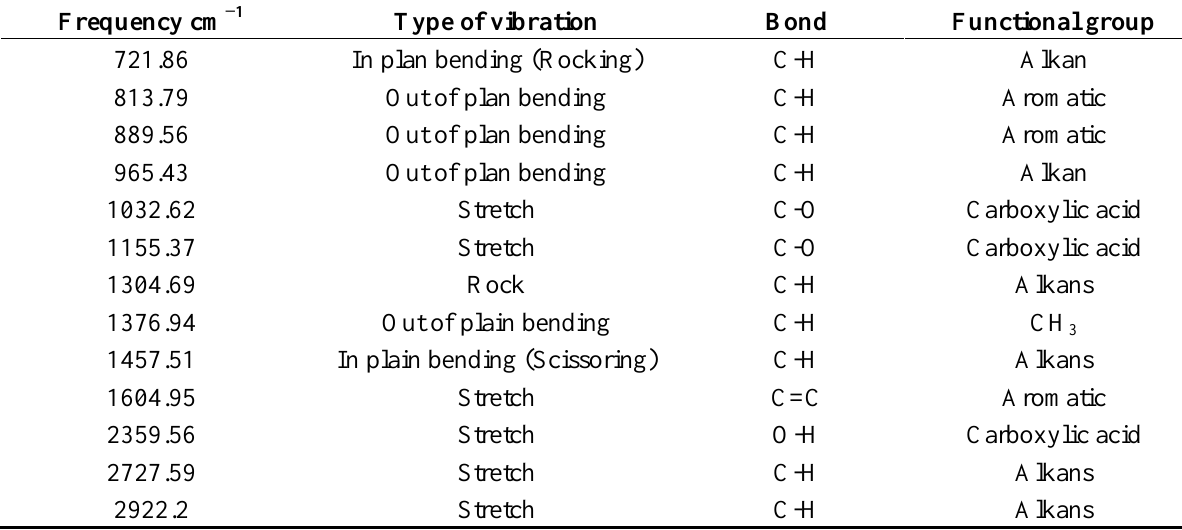
Table 11. Results of analysis of the recycled oil (base oil only before adding the additives) by vacuum distillation-clay method in local companies in